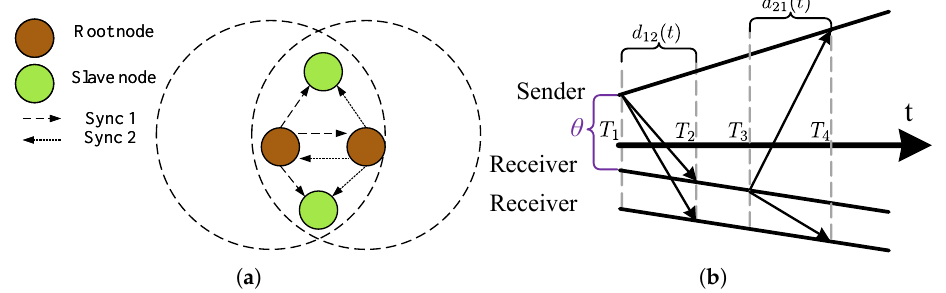
Figure 17. Receiver-only messaging scheme, where a pair of nodes exchanges synchronization message, and all of their common neighbors overhear this communication. Each receiver synchronizes to the time of these nodes. In ( a ), a typical operation of the scheme, and in ( b ), timeline of message